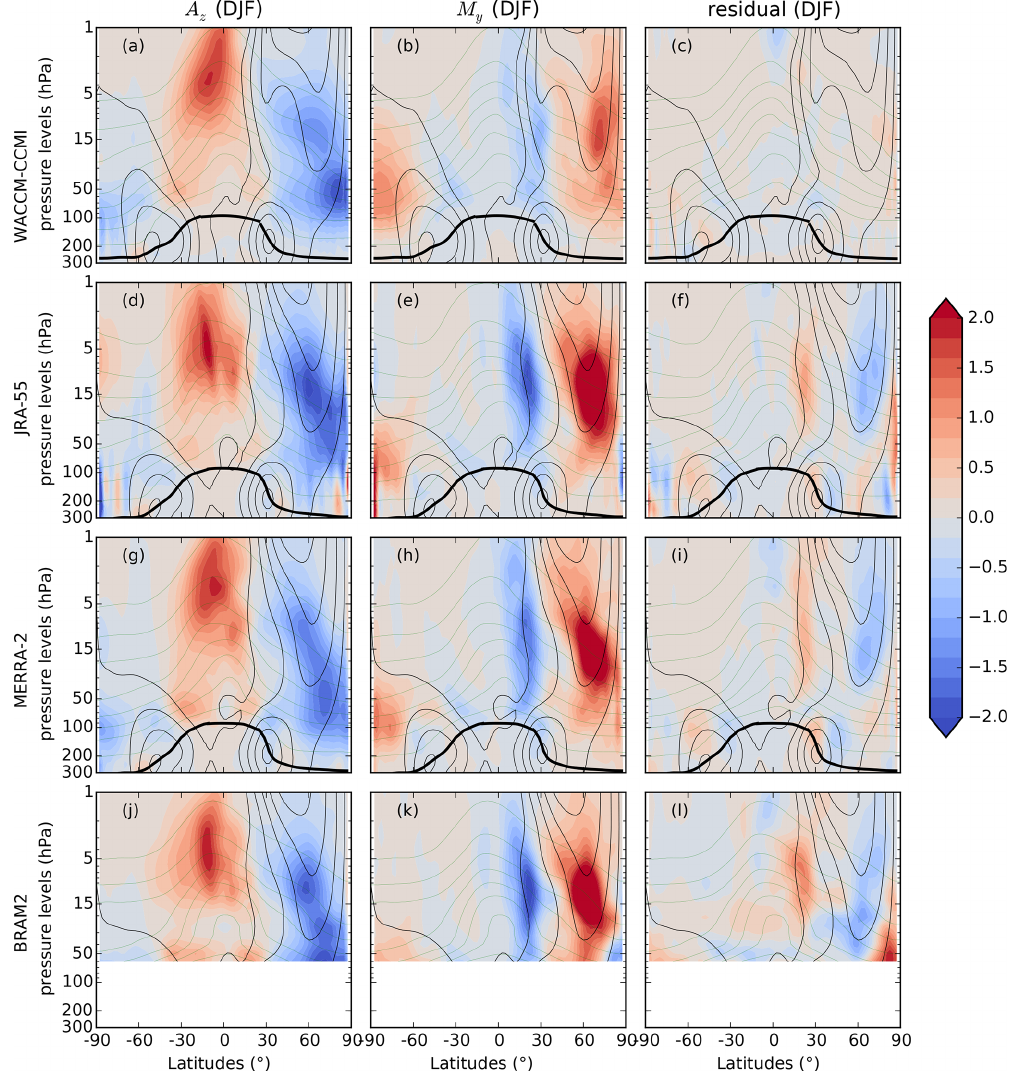
Figure 3. Climatological (2005–2014) latitude–pressure cross sections of three N 2 O TEM budget terms averaged in DJF (ppbvd − 1 ) for the horizontal mixing term (a, d, g, j) , the vertical residual advection term (b, e, h, k) and the residual term (c, f, i, l) . The datasets are, from top to bottom, WACCM-CCMI, JRA-55, MERRA-2 and BRAM2. The residual term for WACCM-CCMI is from a single realization of the model. The thin black lines show the zonal-mean zonal wind (from 0 to 40ms − 1 every 10ms − 1 ), the black thick line represents the dynamical tropopause for the considered season and the green thin lines show the climatological mixing ratio of N 2 O (from 20 to 300ppbv with 40ppbv